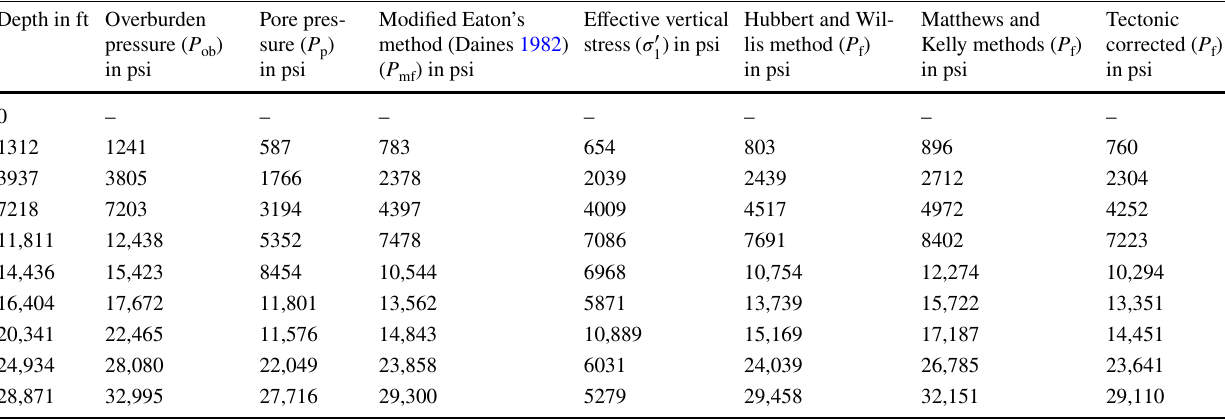
Table 2 Predicted fracture pressure on the Atharamura anticline top Depth in ft Overburden pressure ( P ob